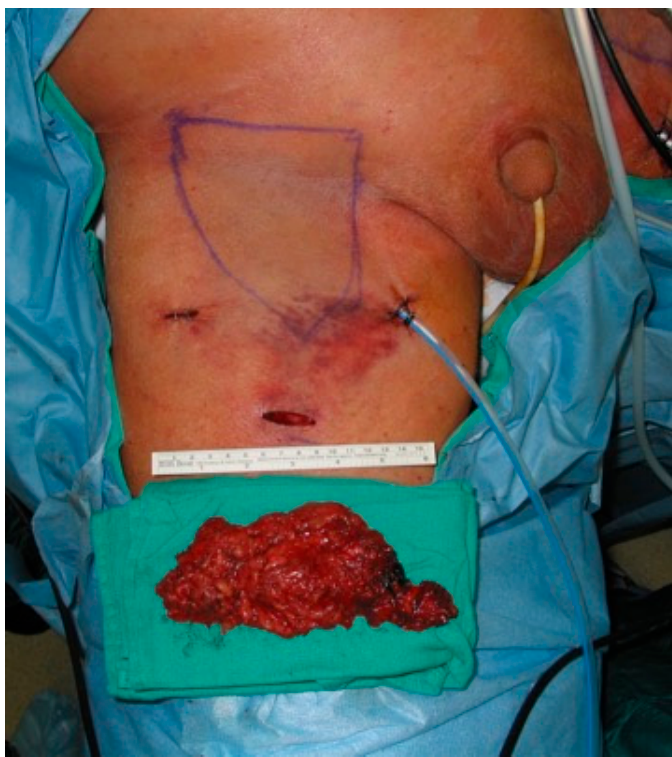
Figure 6. Lymph node packet is retrieved, and a closed-suction drain is placed through one of the port sites. Copyright owned by Master et al.